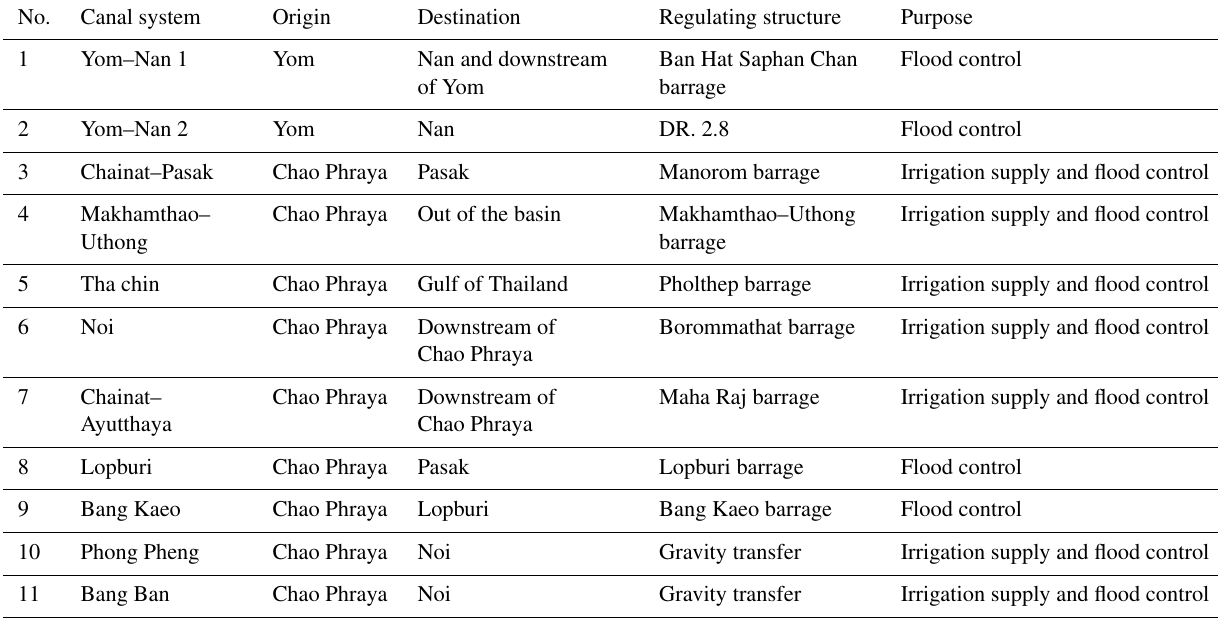
Table 1. Origin and destination points of the canal systems in the CPRB with their regulating structures and purpose.